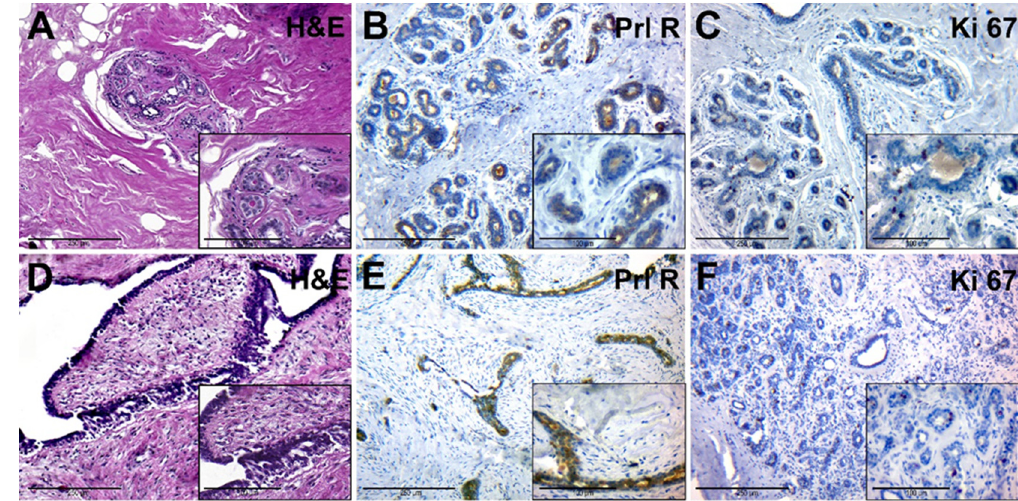
Figure 3. Histological and immunohistochemical examination of tissue samples from patients with normal levels of serum PRL. ( A – C )—adjacent breast tissue of patients with normal levels of serum PRL (group IA). ( A )—hematoxylin-eosin staining; ( B )—IHC detection of PRL-R expression; ( C )—IHC expression of Ki-67. ( D – F )—BBT tissue (FA) of patients with normal levels of serum PRL (group IB). ( D )—hematoxylin and staining; ( E )—IHC detection of PRL-R expression; ( F )—IHC expression of Ki-67. Magnification (including inserts) is indicated in the lower-left corner of the image as a marker.